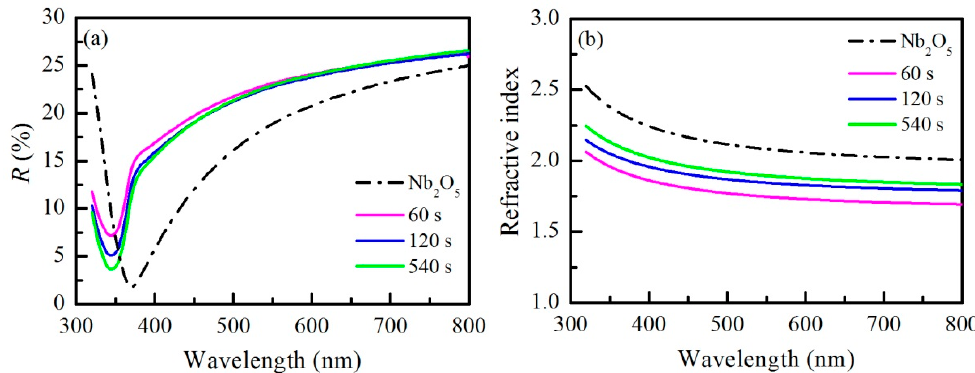
Figure 6. Reflectance spectra ( a ) and dispersion curves of the refractive index ( b ) of thin Nb 2 O 5 films and composite films of Nb 2 O 5 doped with 5% Na ‐ X zeolites milled for 60 s, 120 s, and 540 s. Table 2. Refractive index n , extinction coefficient k, thickness d, surface rms roughness S q , and